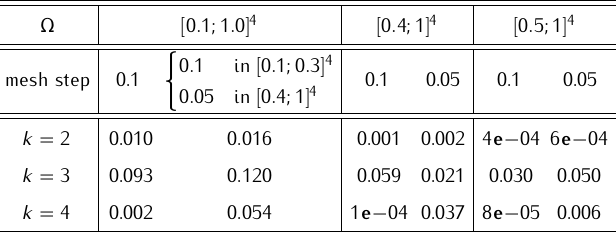
Table 2. Squared 2-vector norm of the residual (approximation with a polynomial of k th degree), Manchester, January